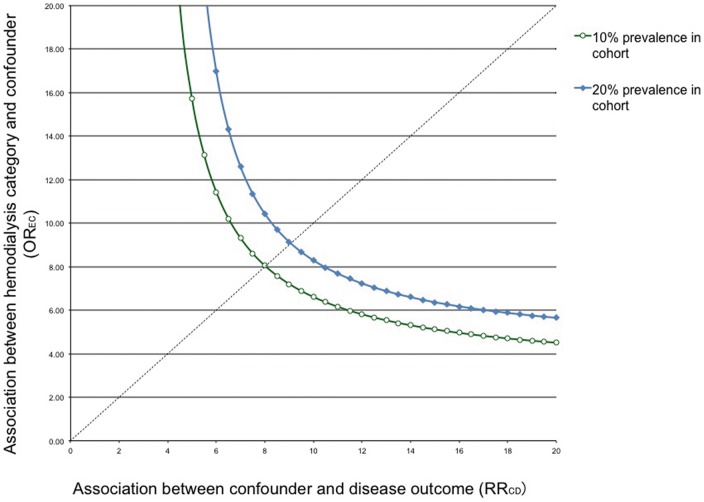
Sensitivity analyses of an unmeasured confounding.